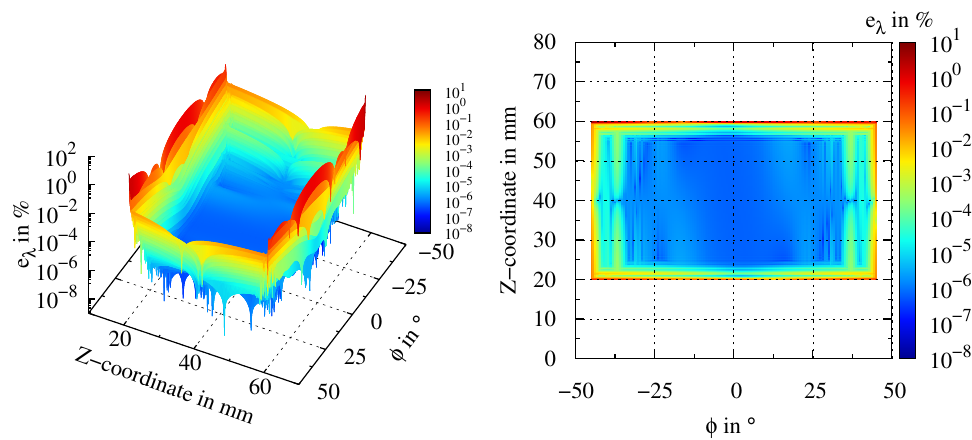
Figure 2. Relative error of maximum principal stretch (Wendland function withmonomials, R 0 = 1.5mm, ∆ d = 0.15mm) showing the boundary region effect of RBFs; ( left ) 3D represen- tation, ( right ) 2D